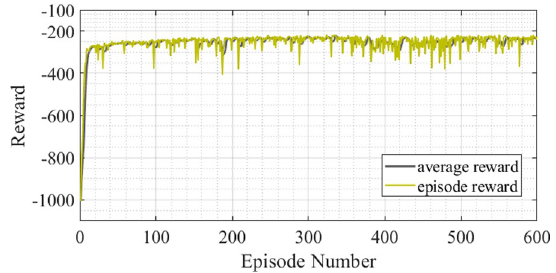
Fig. 3 Episode and average rewards during the training process